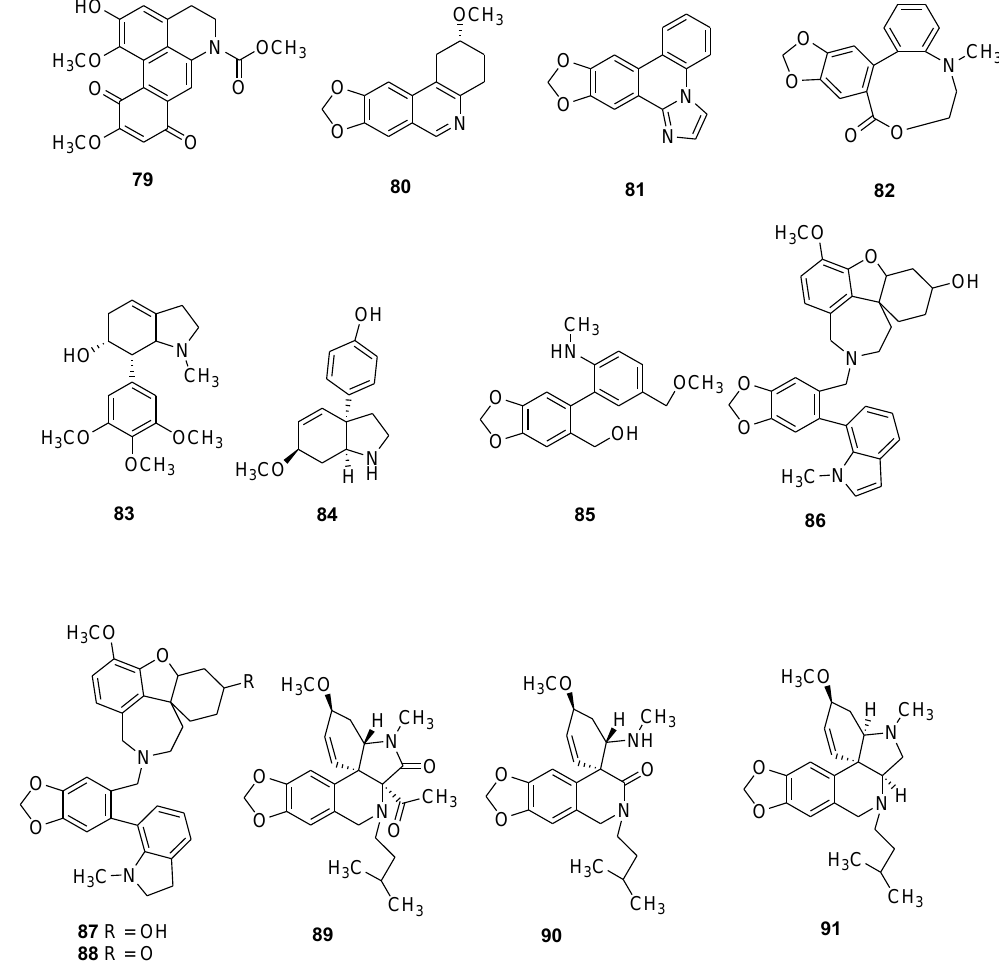
Figure 7. Chemical structure of new alkaloids of other types. Numbers in bold refer to the compounds depicted in Table 2.